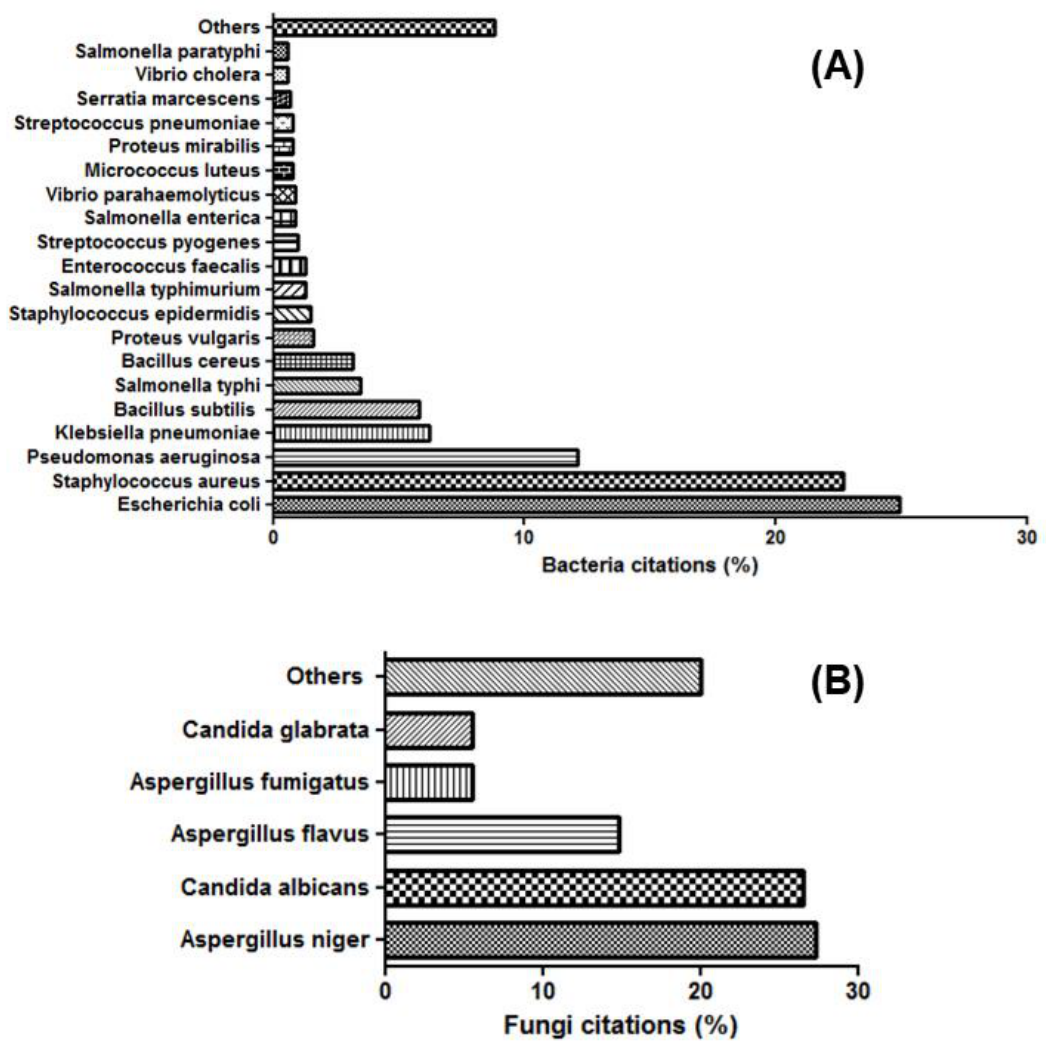
Figure 7. ( A ) Percentage of bacteria citations ( n = 2065). Others (8.8%) include ca. 70 bacterial species, such as Acinetobacter baumannii , Bacillus megaterium , Enterobacter cloacae , Klebsiella planticola , Pseudomonas putida , Staphylococcus saprophyticus and Shigella dysenteriae . ( B ) Percentage of fungi citations ( n = 326). Others (20.0%) include ca. 15 fungal species, such as Aspergillus terreus , Candida krusei , Candida freundii , Fusarium oxysporum , Penicillium italicum , Penicillium notatum and Phanerochaete sordida .